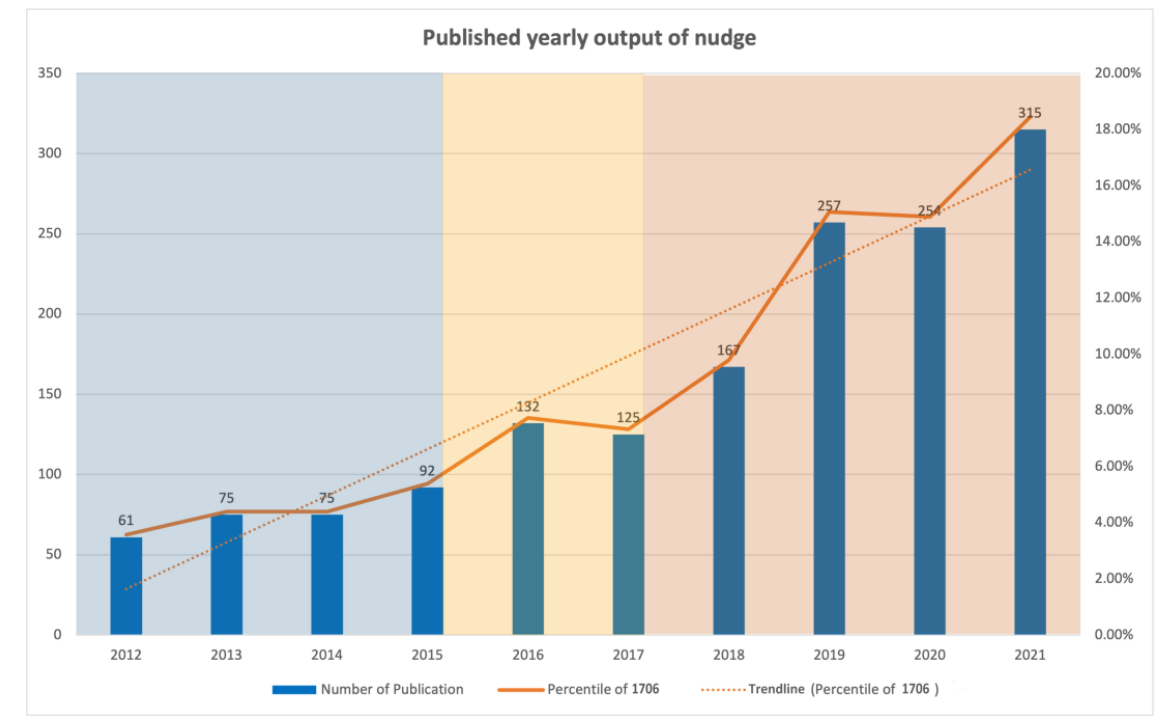
Figure 2. Published yearly output of nudge.